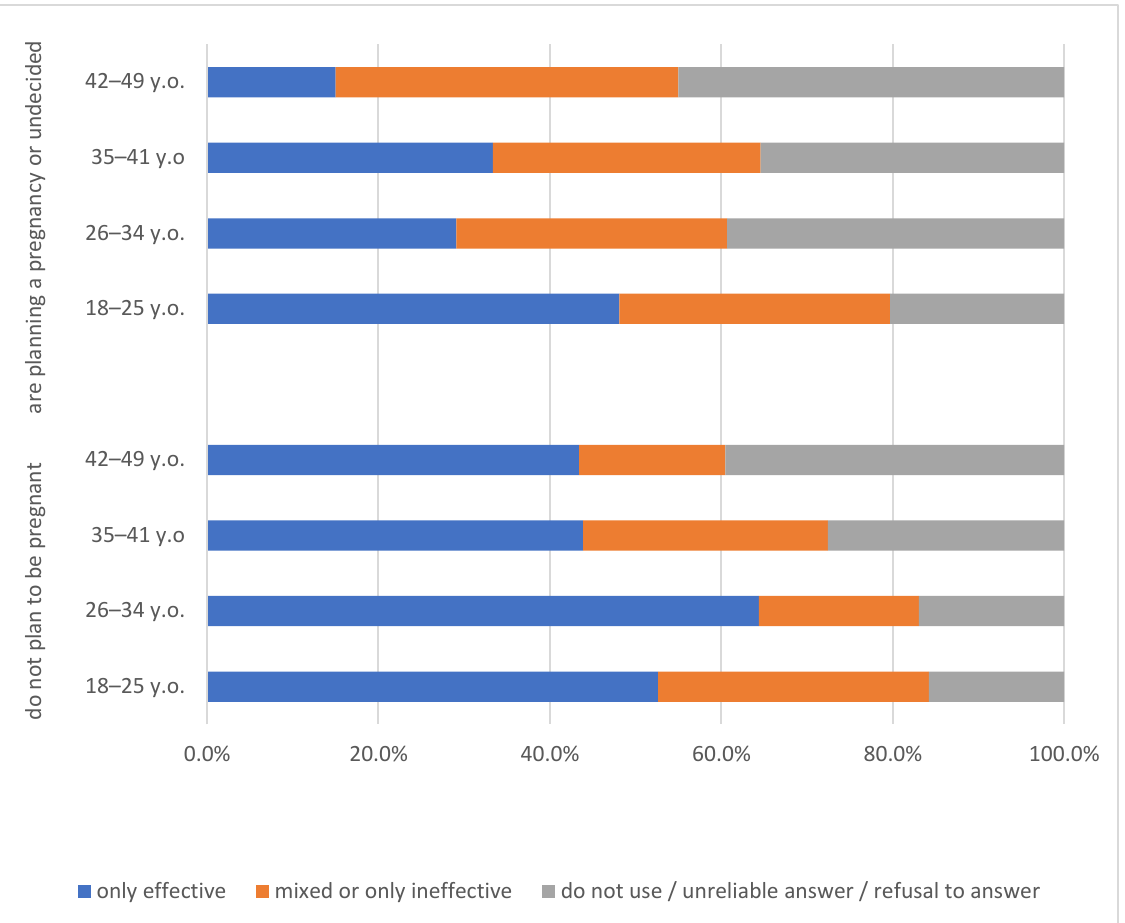
Figure 1. Contraception models in comparison with the age of women not planning and planning to have children .